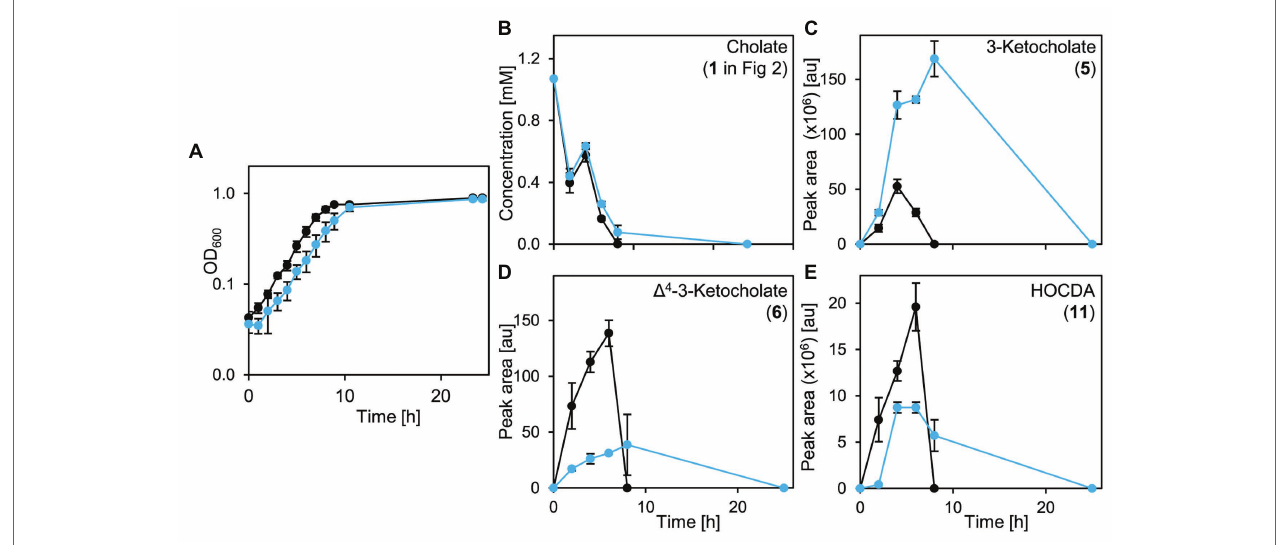
FIGURE 7 | Growth of Sphingobium sp. strain Chol11 wt (black) and Δ 5 β -Δ4-kstd1 (blue) with cholate ( 1 in Figure 2 ; A ), degradation of cholate (B) and accumulation of intermediates 3-ketocholate ( 5 in Figure 2 , C ), Δ 4 -3-ketocholate ( 6 , D ) and HOCDA ( 11 , E ) in the cell-free culture supernatant. Error bars indicate SD and may not be visible if too small ( n =